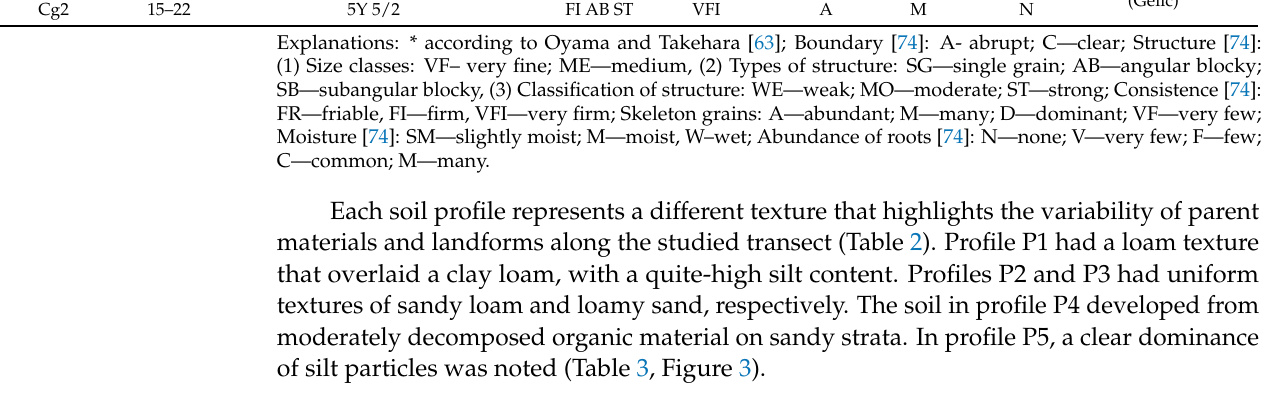
Table 3. Basic chemical and physical soil